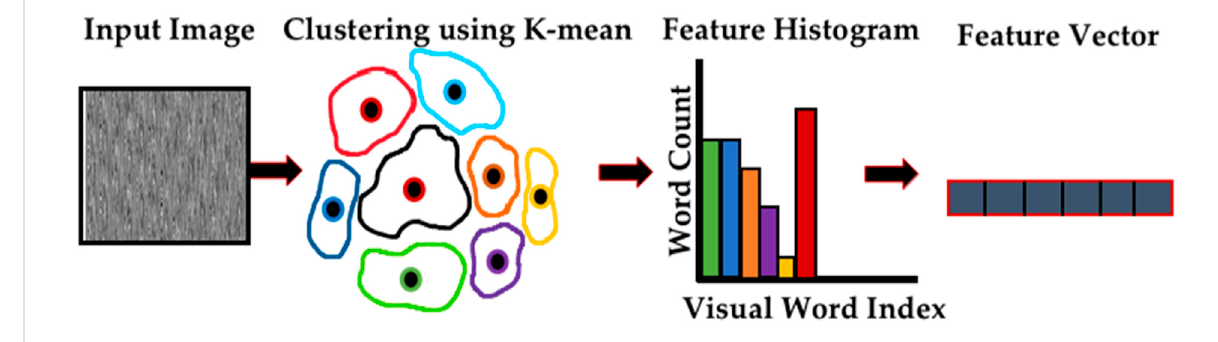
FIGURE 1 A representation of the bag of visual words extraction process.